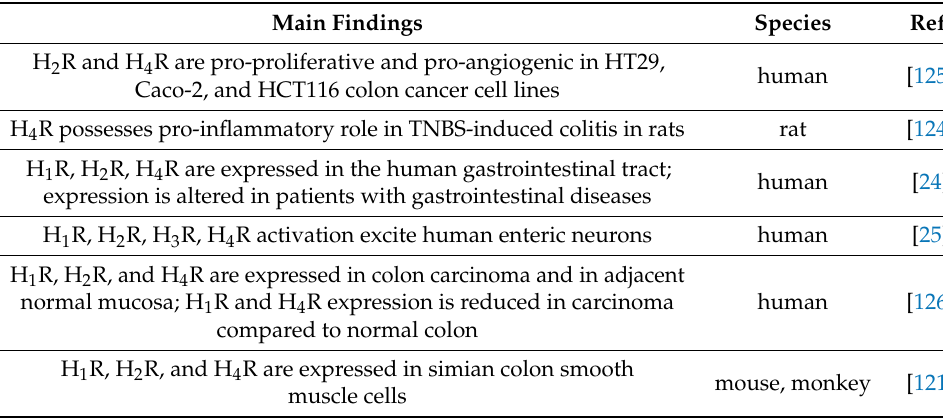
Table 2. Studies on H 4 R in the gastrointestinal tract. Main Findings Species